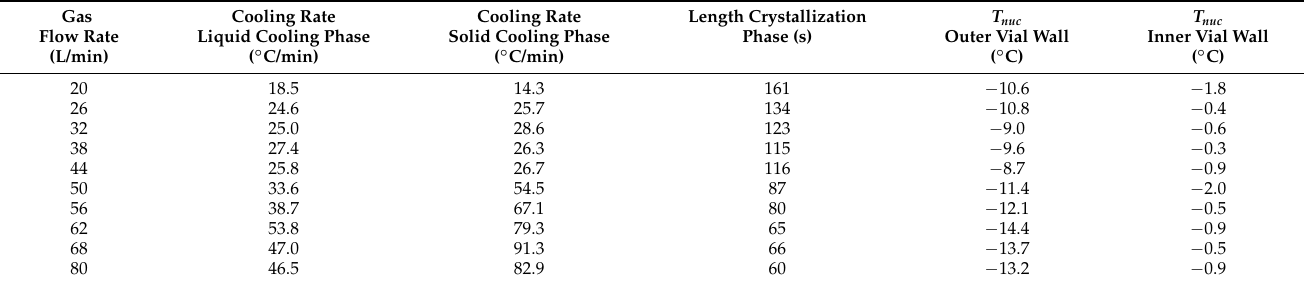
Table 2. Relevant experimental data from verification